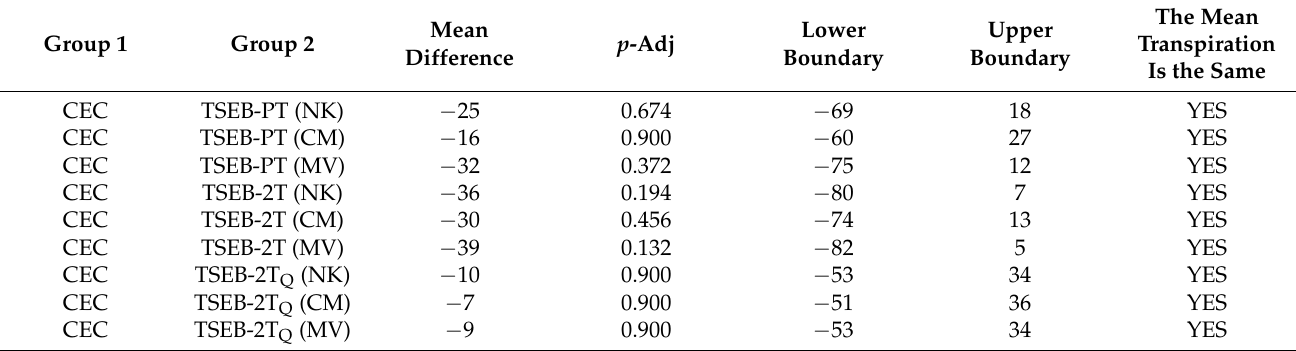
Table A5. ANOVA and Tukey test results showing the difference between the transpiration calculated via the CEC method and the transpiration modeled via the TSEB models. The null hypothesis is that the mean transpiration between different groups is the same. “Mean difference” is the mean difference between “Group 1” and “Group 2.” “Lower boundary” and “Upper boundary” are the lower and upper 95% confidence interval boundaries, respectively. “CEC” represents the transpiration calculated via the CEC method. The unit for “Mean difference,” “Lower boundary,” and “Upper boundary” is Wm − 2